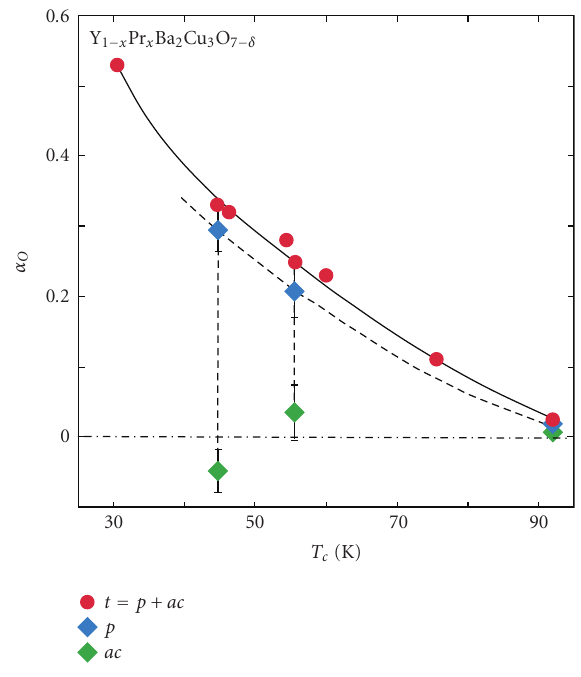
high dielectric constants observed in cuprate HTSs [63]. In